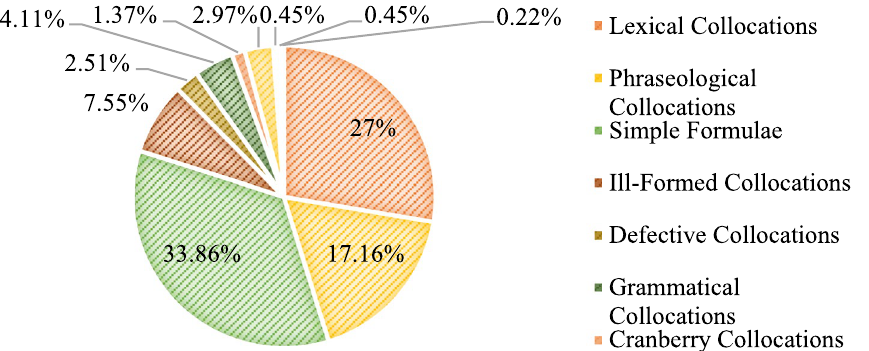
Fig. 6 Percentages of each phraseological unit type used in band scores 5–5.5